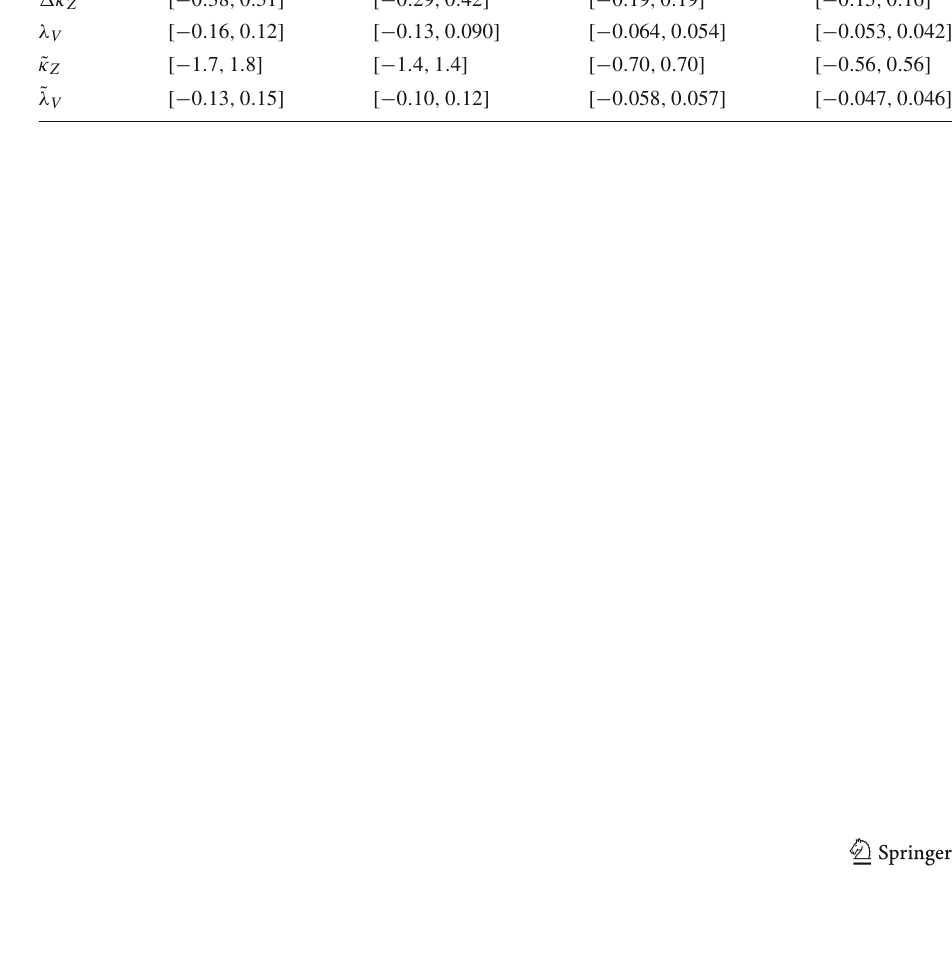
95% C.L. allowed ranges for all aTGC parameters considered with the other parameters set to their SM values. A form factor with unitarization scale equal to 4 TeV enforces unitarity for all aTGC parameters. The results are derived from the high- q 2 region yields given in Table 4